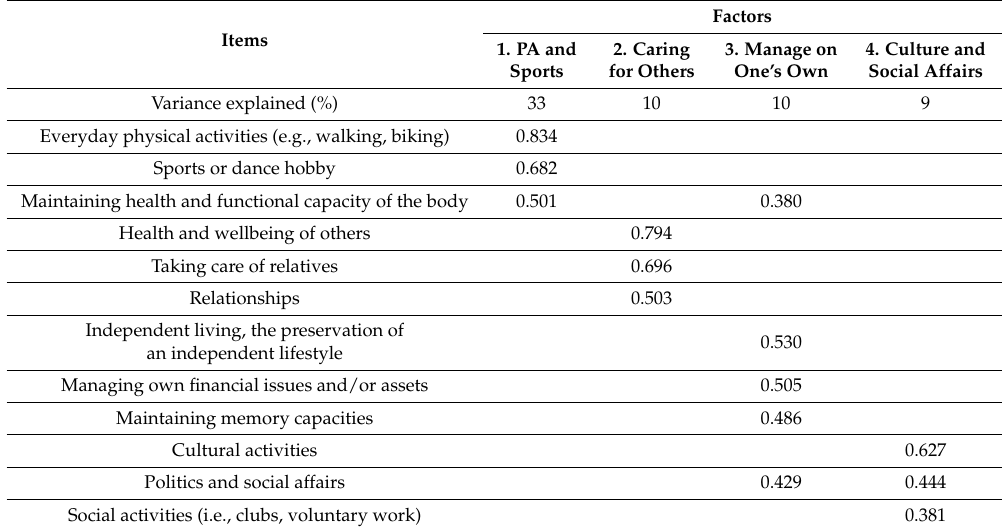
Table 2. Explanatory factor